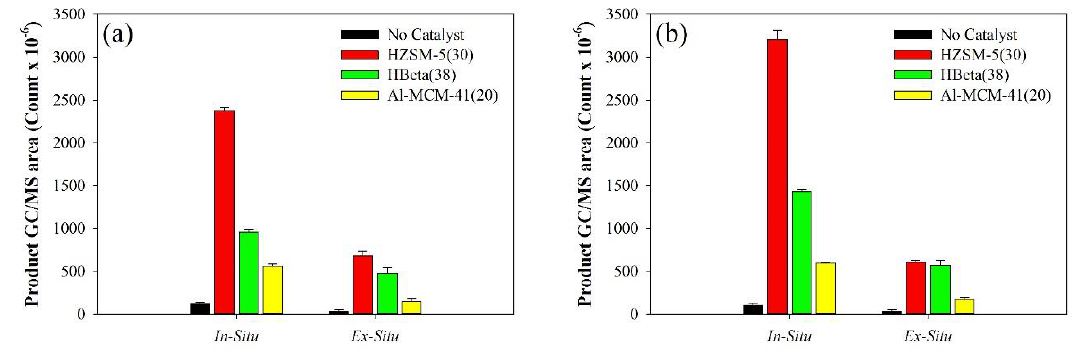
Figure 7. Comparison of GC/MS areas (count × 10 -6 ) for total aromatic hydrocarbons (TAHs) obtained from the catalytic pyrolysis of ( a ) TP-1 and ( b ) TP-2 at 650 °C.